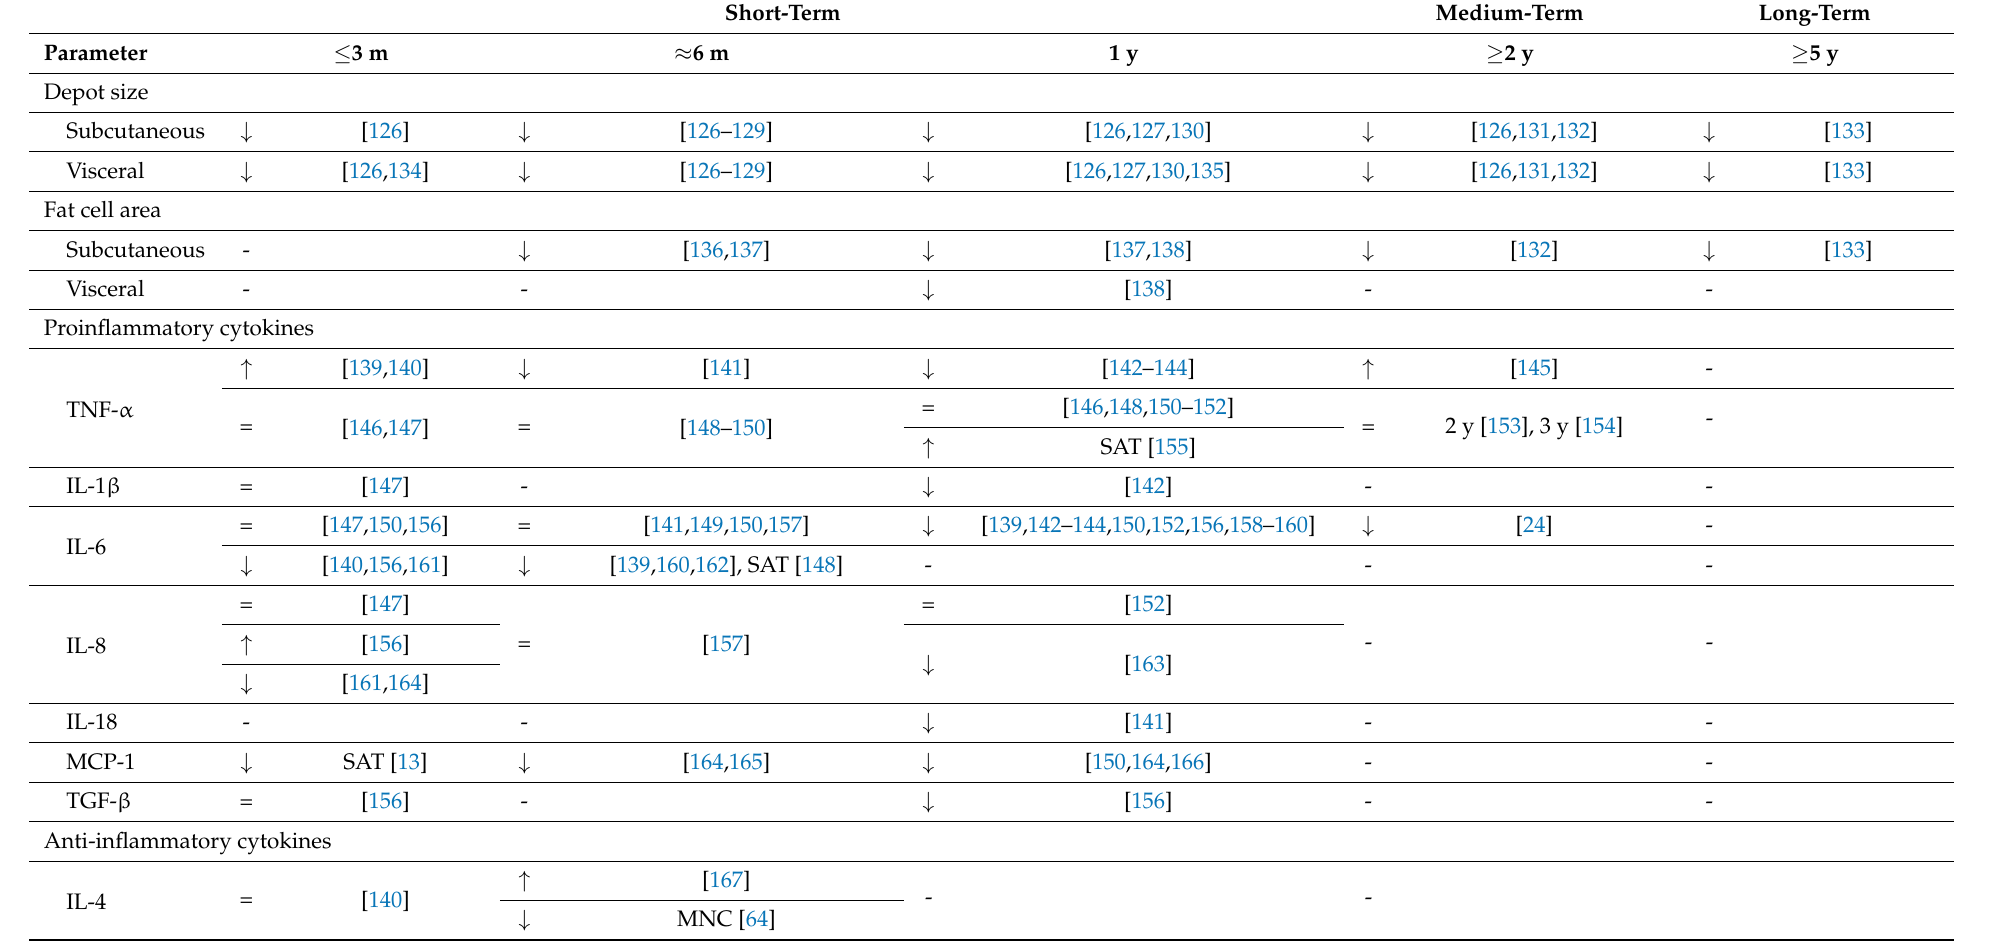
Table 1. Short-, medium- and long-term outcomes of bariatric surgery on fat depot parameters, circulating and adipose tissue expression levels of cytokines, adipokines, and microRNAs. Short-Term Medium-Term